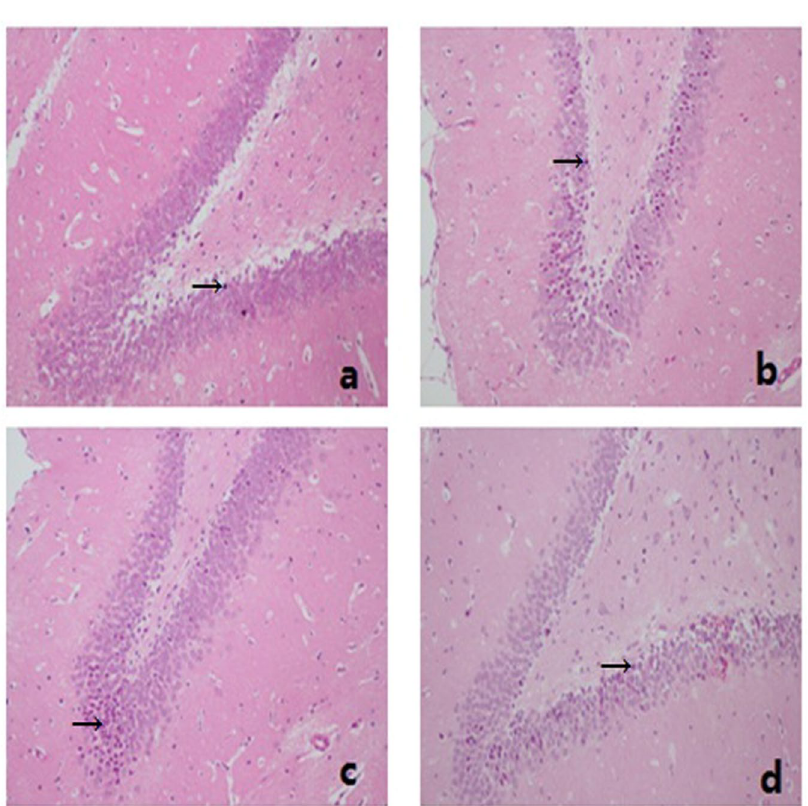
Figure 3. Histopathological examination of H&E stained sections of Hippocampal CA1. Neuronal cells in Hippocampal CA1 in control group ( a ); NS ( b ); HS ( c ) and HES groups ( d ). Black arrow points neuronal cells with nuclear staining was purple red with chromatin condensation. magnification,